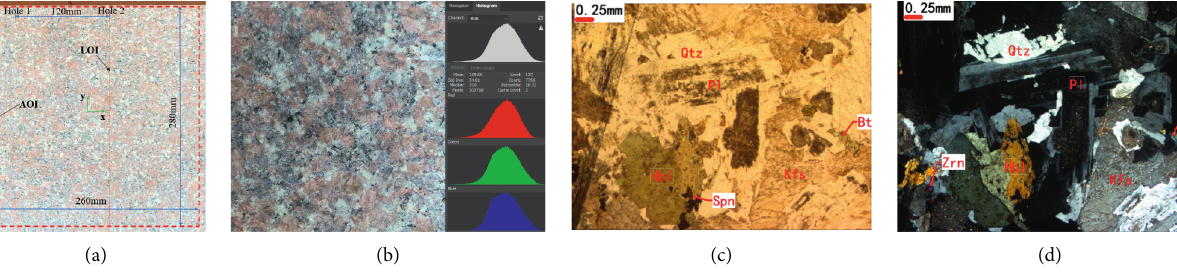
Figure 3: Granite specimen. (a)Area of interest for test 1 and test 2; (b) gray value; (c) plane-polarized light; (d) cross-polarized